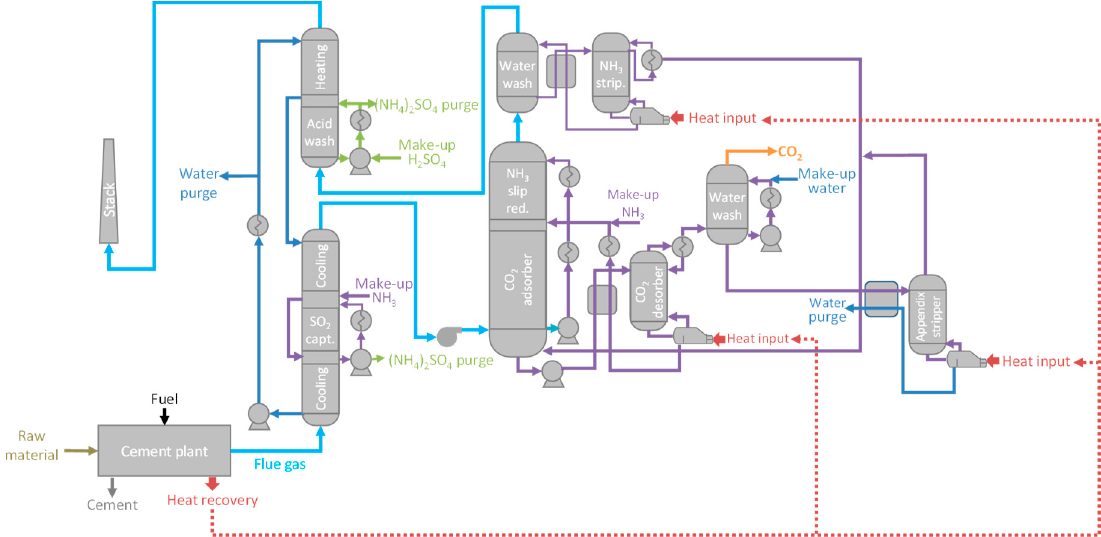
Figure 6. Process flow sheet of a CAP process integrated in a cement plant (adapted from [46]).